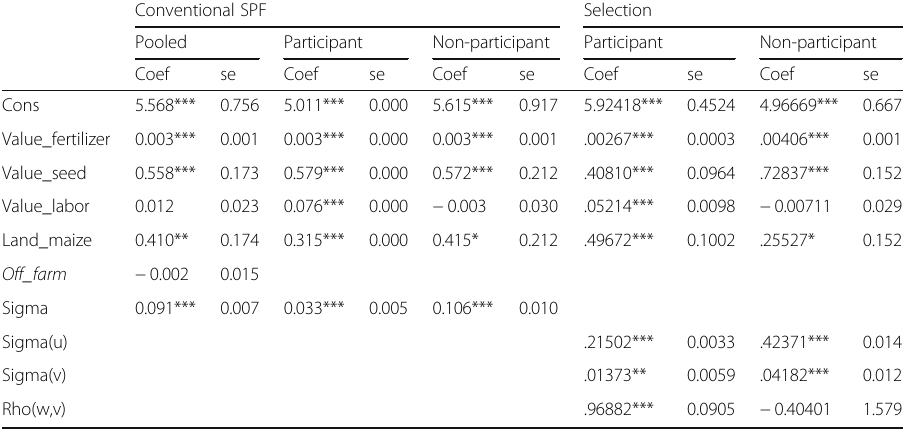
Table 4 Conventional and selection SPF based on unmatched observation Conventional SPF